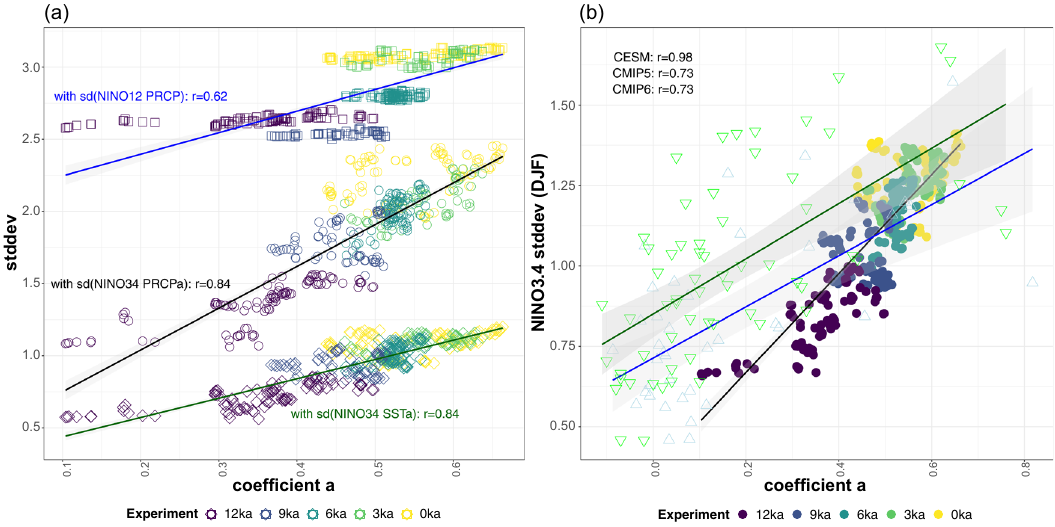
Fig. 3| Therelationshipbetween ElNiño-SouthernOscillation(ENSO)diversity andtropicalPaci fi csea-surfacetemperature(SST)andprecipitationvariability in pre-industrial control and paleoclimate model experiments. ENSO diversity is measured by the coef fi cient α of the quadratic fi t in the December-January- February (DJF) PC1-PC2 plane; positive α indicates a concave down shape in the PC1 – PC2 space, as in Supplementary Fig. 2. a Standard deviation of monthly hydroclimate variables in the central and eastern Paci fi c vs. ENSO diversity. Points correspond to 100-yr samples from each experiment with the Community Earth SystemModelv1(CESM1),withtheircolorsindicatingthetimesliceandtheirshape indicating the variable plotted: diamonds and circles for the standard deviation of SST and precipitation anomalies in the central Paci fi c (NINO3.4 region), respec- tively,andsquaresforthestandarddeviationoftotalprecipitationinthefareastern Paci fi c(NINO1+2region).Shading indicatesuncertaintyinthe regressionlines.The